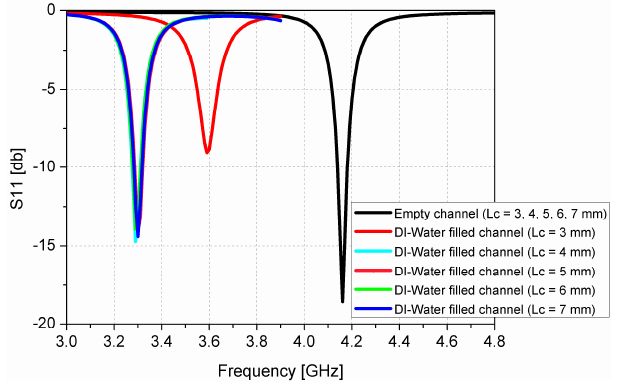
Figure 5. Simulated S 11 of the proposed sensor with the empty and DI water-filled channel when L C is varied from 3 mm to 7 mm.